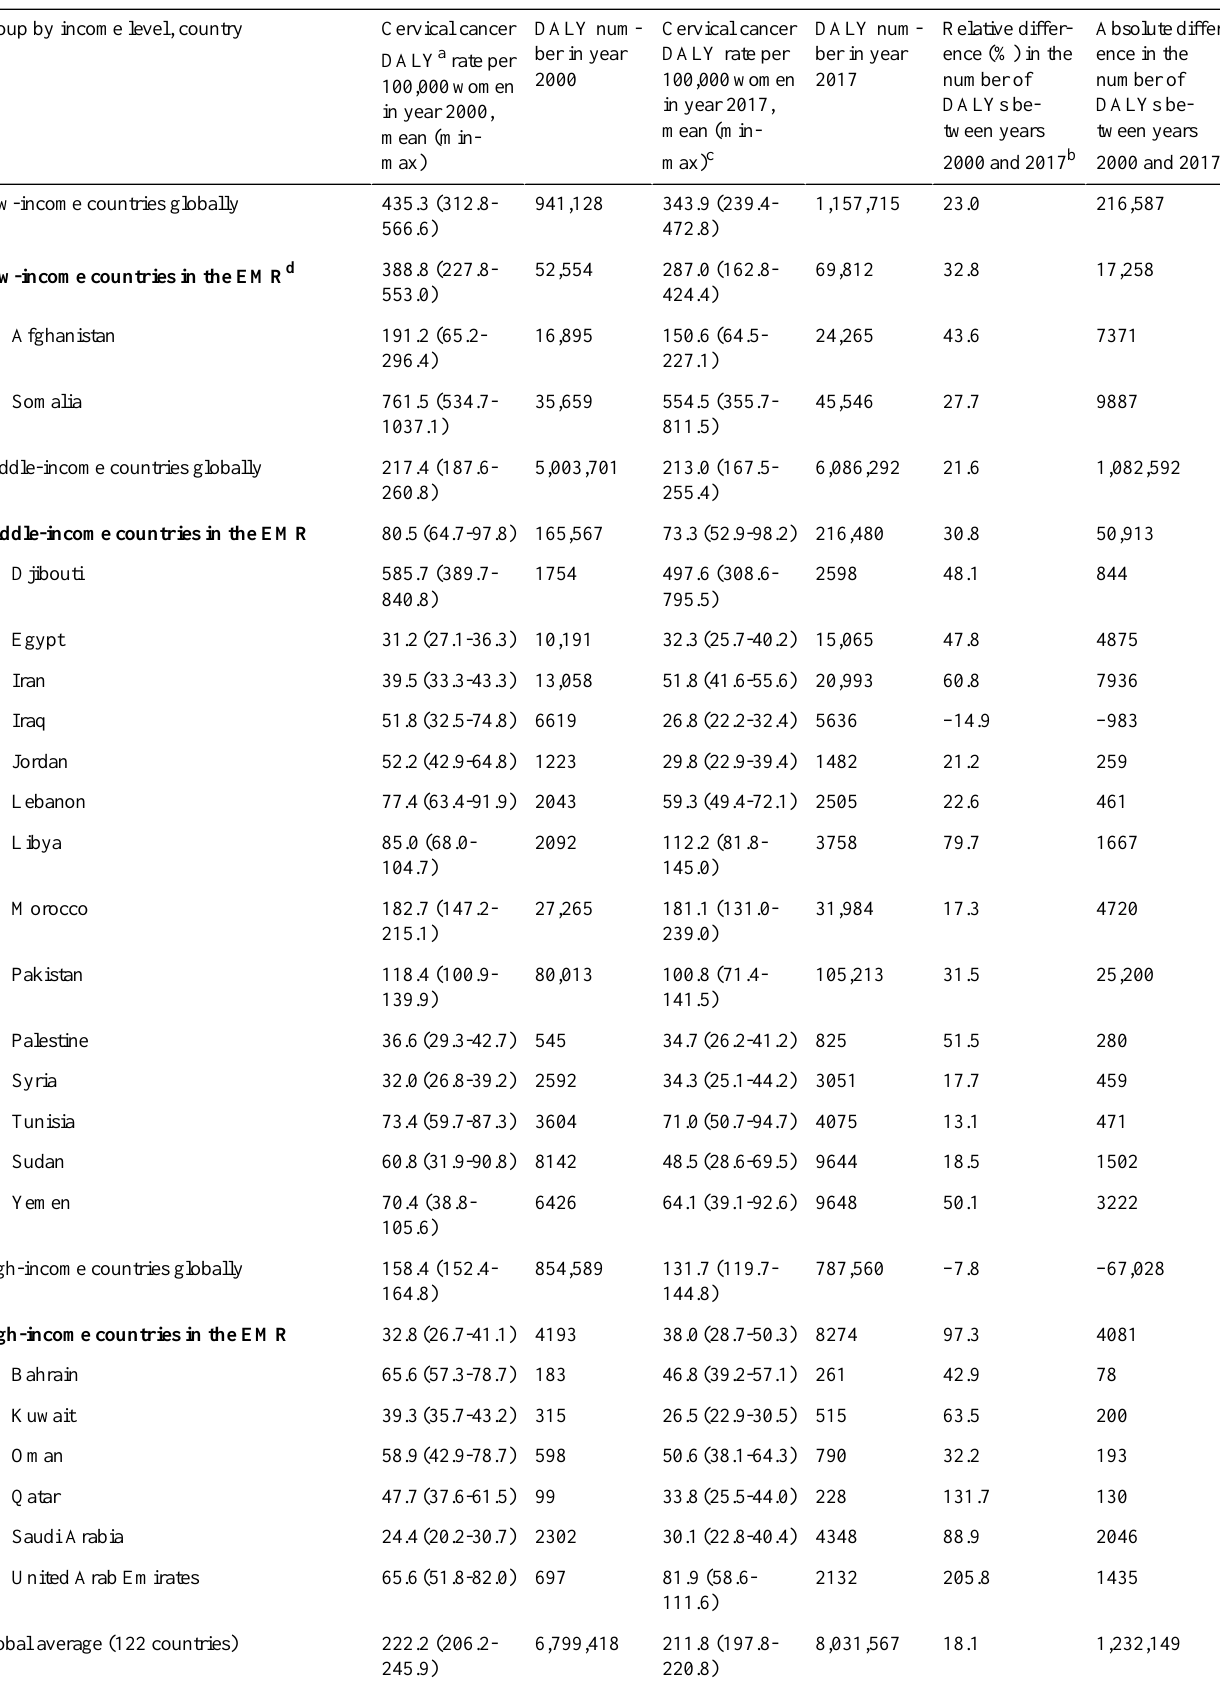
Table 2. Disability-adjusted life years data due to cervical cancer among women older than 20 years in the Eastern Mediterranean Region by country and income level compared to the global average in the years 2000 and